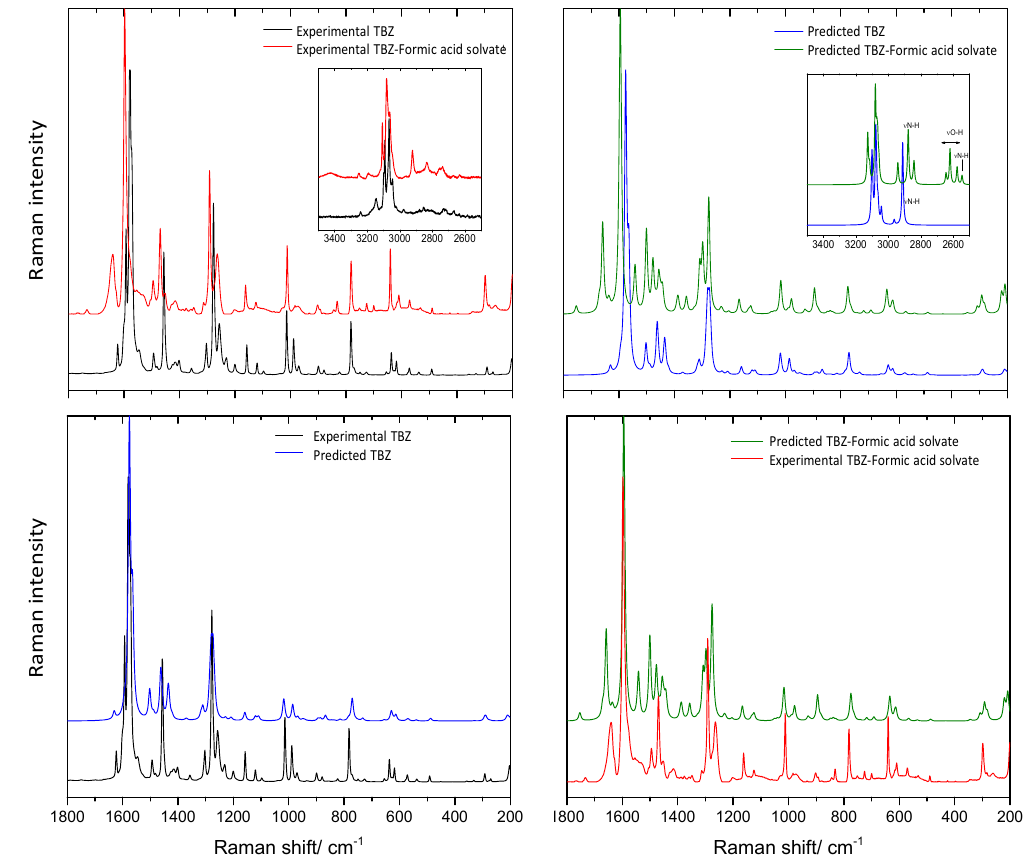
Figure 17. Top: Left panel: Experimental Raman spectra of crystalline TBZ (black) and of TBZ-formic acid solvate (red); Right panel : Periodic B3LYP-D2 / 6-31G / d,p) predicted spectra for the crystals of TBZ (blue) and TBZ-formic acid solvate (green). Bottom: Left panel: Experimental Raman spectra of crystalline TBZ (black) and the corresponding periodic B3LYP-D2 / 6-31G / d,p) predicted spectra (blue); Right panel : Experimental Raman spectra of TBZ-formic acid solvate (red) and the corresponding periodic B3LYP-D2/6-31G/d,p) predicted spectra (green).